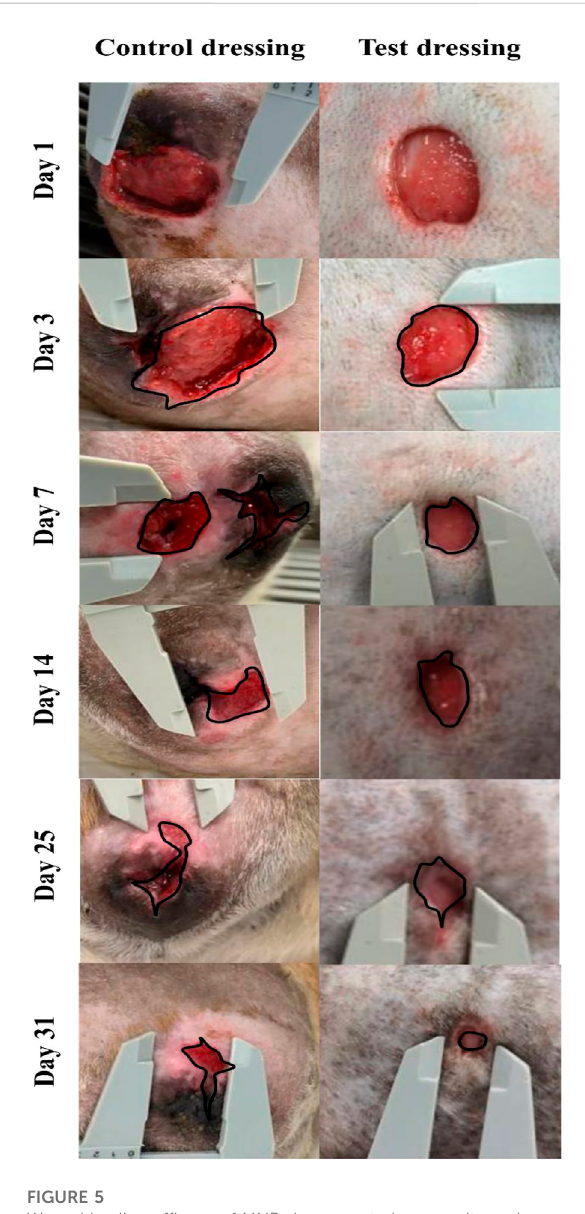
FIGURE 5 Wound healing ef fi cacy of MNPs incorporated composite and control composite assessed on healthy dogs with similar natural wound conditions of any bread, sex, and age visiting at Veterinary Teaching Hospital, Prince of Songkla University, Thailand. Reproduced with permission (Singh et al., 2022a). Copyright 2022, Elsevier.